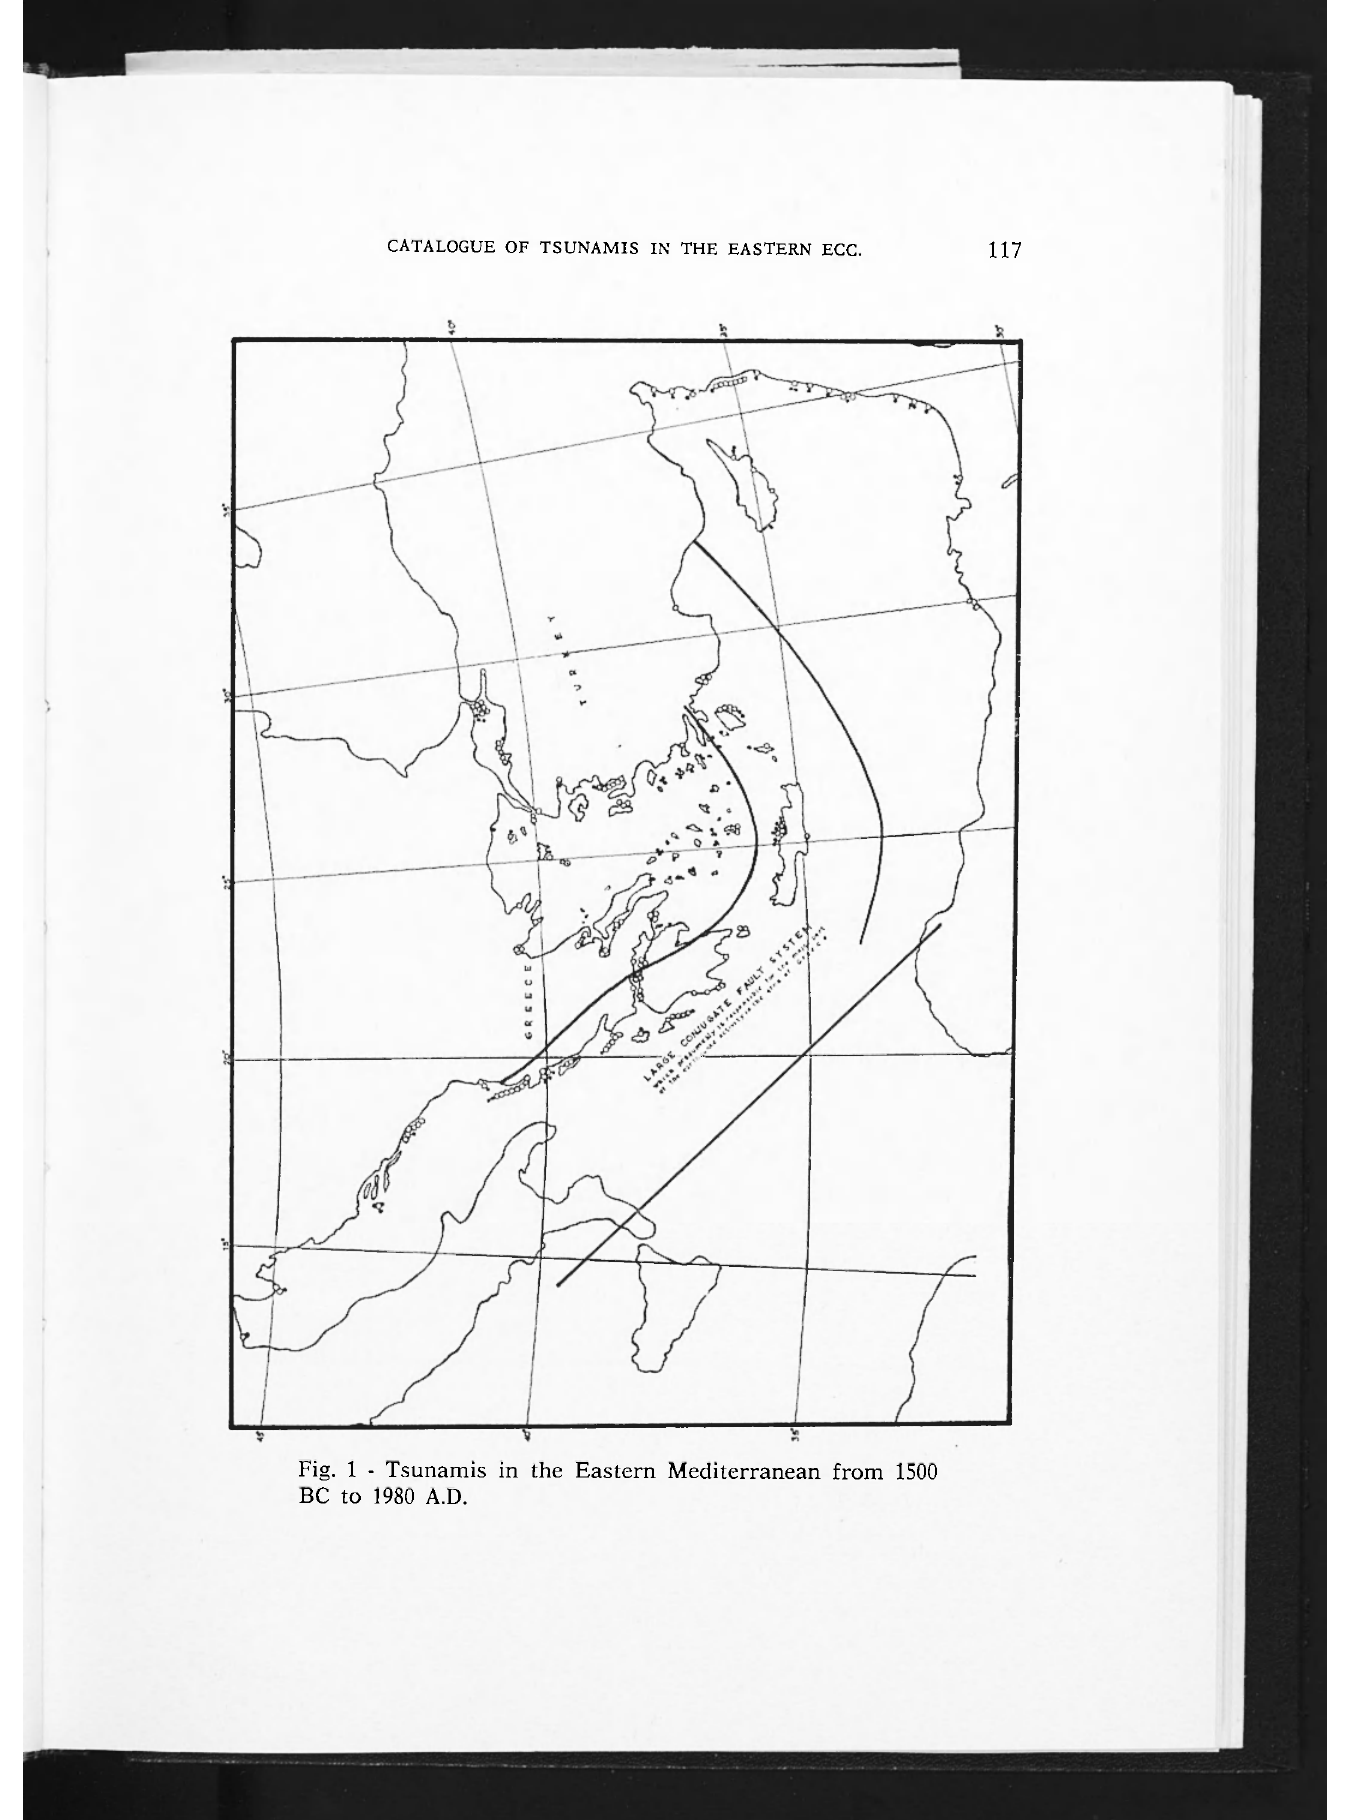
Fig. 1 - Tsunamis in the Eastern Mediterranean from 1500 BC to 1980